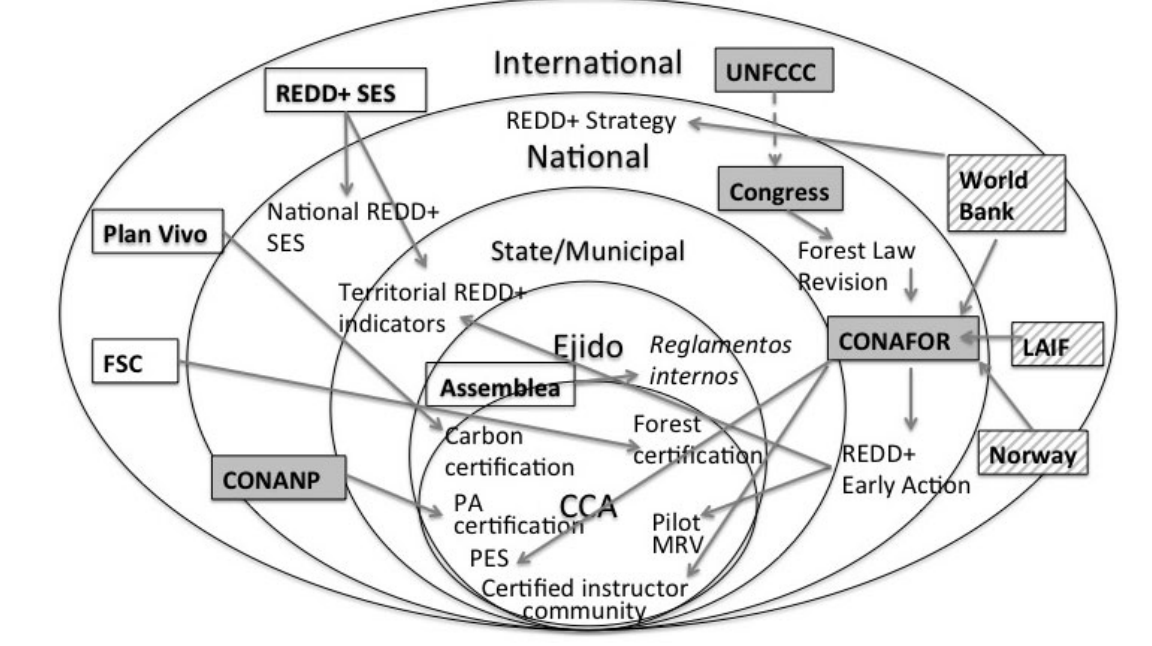
Fig. 1 . Key institutional actors and initiatives relevant to safeguarding REDD+ in Felipe Carrillo Puerto (FCP). This diagram illustrates key institutional actors involved in initiatives that currently affect or intend to affect the safeguarding of REDD+ in FCP. Intergovernmental and governmental actors are indicated by boxes with solid shading, donors by crosshatched boxes, and other institutional types (NGOs, a hybrid public/private organization, and an ejido assemblea) by boxes without shading. The diagram is not exhaustive; the extent and complexity of REDD+ and its associated safeguards is such that it is impossible to illustrate all potentially relevant institutions and activities and the relationships among them. Rather the purpose of this figure is to provide a graphic representation of the institutional dynamics discussed in this